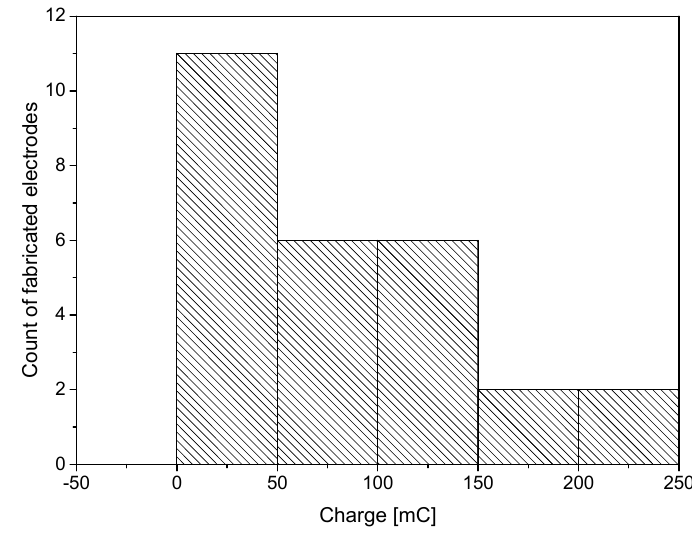
Figure 8. Variability in mercury plating charge during fabrication of gold amalgam microelectrodes (n = 27).